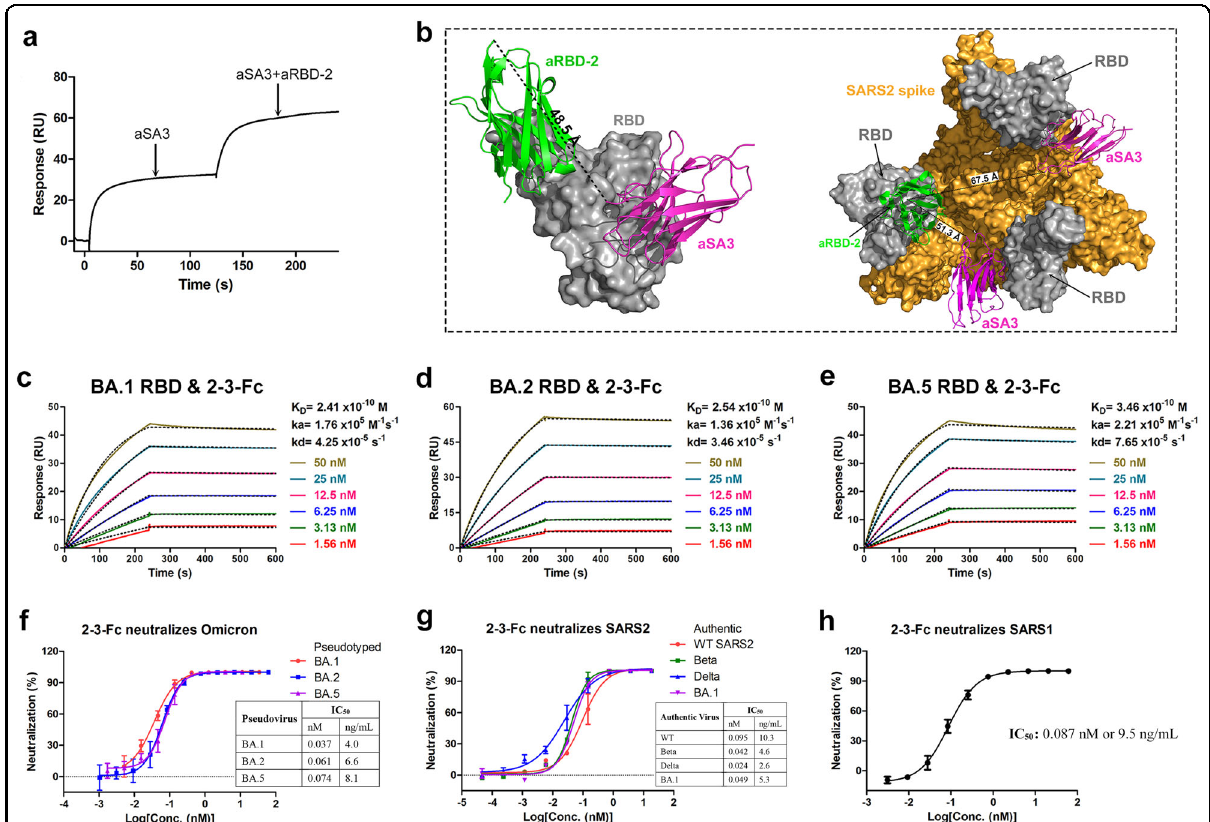
Fig. 3 2-3-Fc tightly binds and potently neutralizes all major VOCs. a Competition between aSA3 and aRBD-2 for binding to the SARS2 RBD was identi fi ed using SPR. SARS2 RBD was immobilized on CM5 chips, and aSA3 was injected for 120 s, followed by injection of a 1:1 mixture of aSA3 in combination with aRBD-2 for 120 s. b The structure of aRBD-2:SARS2 RBD complex (PDB ID: 7FH0) was aligned with that of the aSA3:SARS1 RBD complex (PDB ID: 7X4I) (left). The straight line distance between the C-terminus of aRBD-2 and the N-terminus of aSA3 on one RBD was measured as 48.5 Å. The structures of aRBD-2:SARS2 RBD complex and aSA3:SARS1 RBD complex were superimposed on the RBD in the cryo-EM structures of the trimeric spike with all RBDs in the “ up ” conformation (PDB: 7KMS) (right), and the distance between the C-terminus of aRBD-2 and the N-terminus of aSA3 on two adjacent RBDs was measured as 51.3 Å or 67.5 Å. The length of the fl exible 4(G 4 S) linker is approximately 72 Å in an extended form. c – e SPR kinetics of 2-3-Fc to the RBD of Omicron BA.1 ( c ), BA.2 ( d ), and BA.5 ( e ). The actual responses (colored lines) and the data fi tted to a 1:1 binding model (black dotted lines) are shown. f The neutralization properties of 2-3-Fc against pseudotyped BA.1, BA.2, and BA.5. g The neutralization properties of 2-3-Fc against authentic WT, Beta, Delta and BA.1 viruses. h The neutralization properties of 2-3-Fc against pseudotyped SARS1. The IC 50 values were calculated by fi tting the inhibition rates against antibody concentrations with a sigmoidal dose-response curve. Error bars indicate the means ± SD from three (pseudovirus) or two replicates (authentic